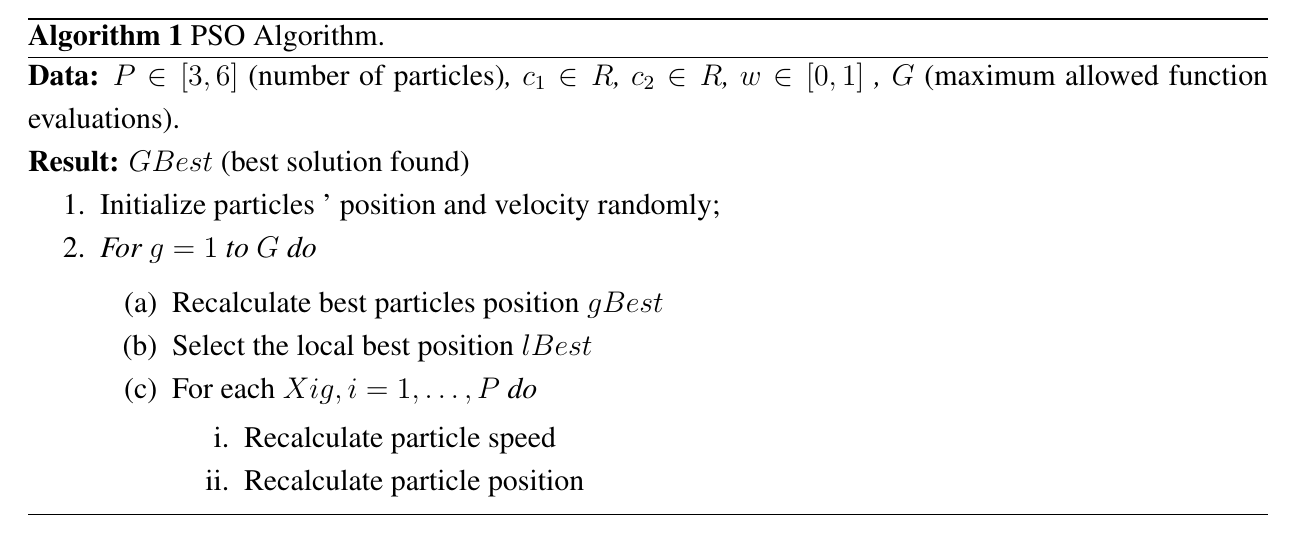
Algorithm 1 PSO